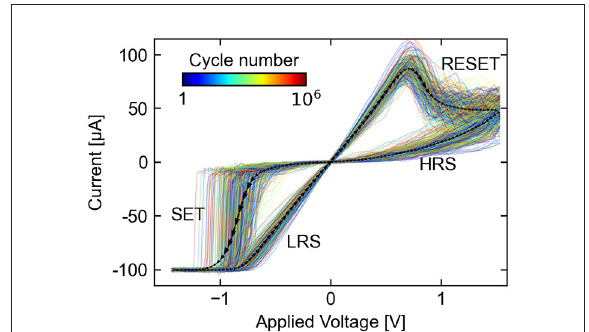
FIGURE5 A subset of the 10 6 measured ( I , U ) cycles used as input to the stochastic model. The black arrowed path shows the average ( I , U ) curve and its temporal direction. Different cycle indices are represented by colored paths, which show significant statistical